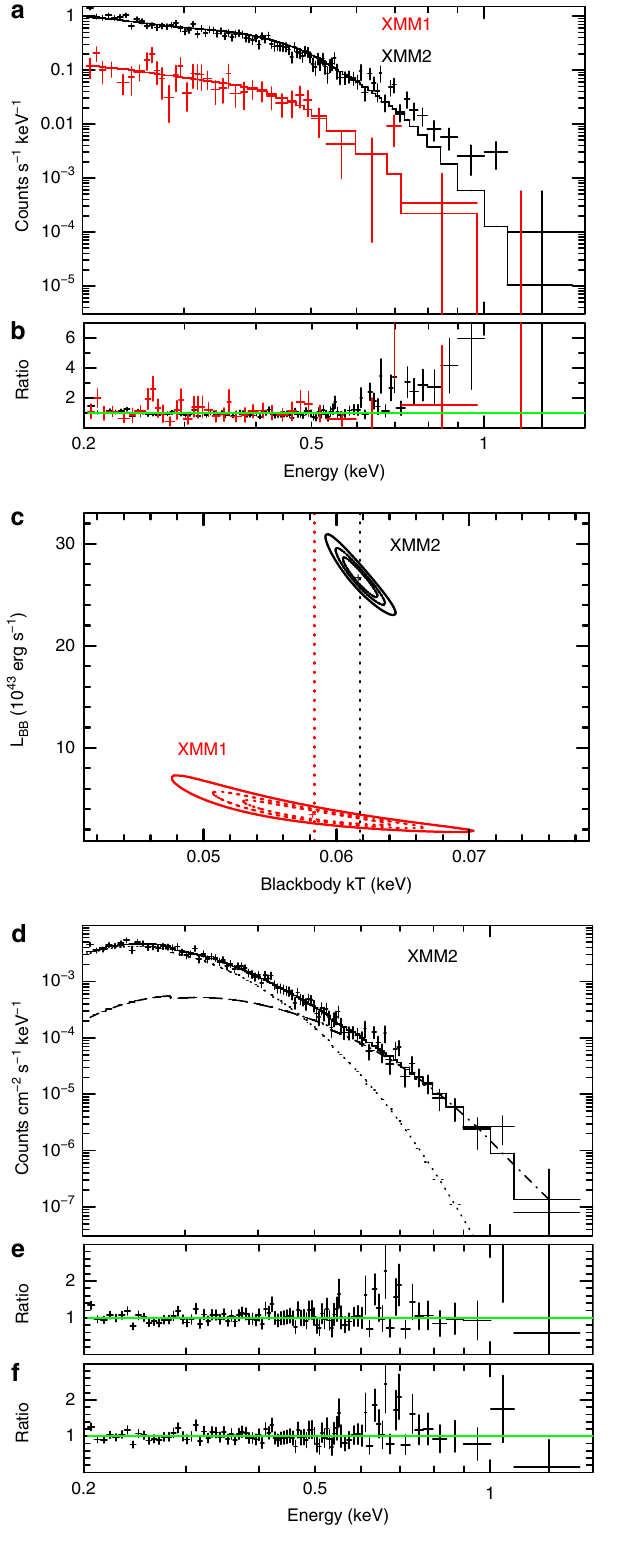
Optical to X-ray SED . Figure 3 shows the UV and optical SED of the transient for epochs where the quasi-simultaneous Swift UV and OGLE I-band observations are available, along with the best- fi tting blackbody curves. The host UV fl ux is estimated from the host SED fi tting (see “ Methods ” : UV to optical SED analysis) and subtracted from the observed emission. The blackbody fi tting